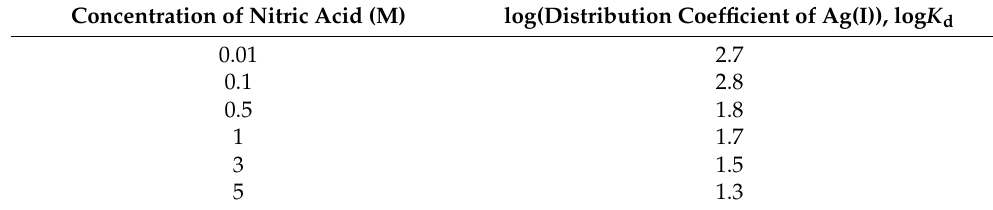
Table 1. Distribution coefficient of Ag(I), when the concentration of nitric acid varied from 0.01 to 5 M at 298 K (n = 4, p =